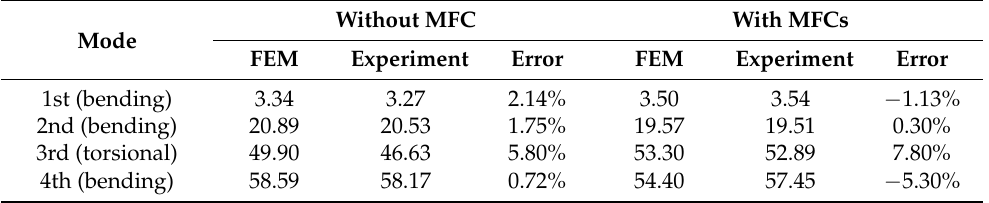
Table 2. Natural frequencies of the structure with and without MFCs (Hz).